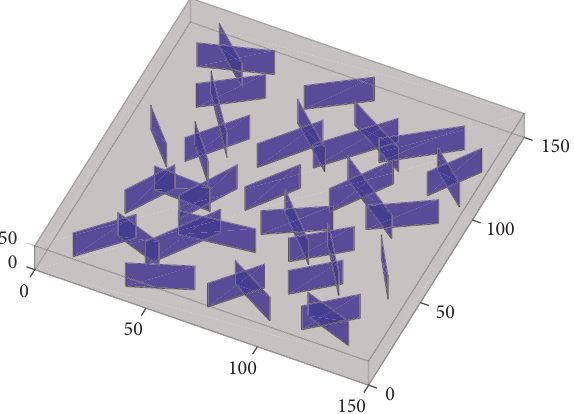
Figure 20: Structure of the fractured reservoir.